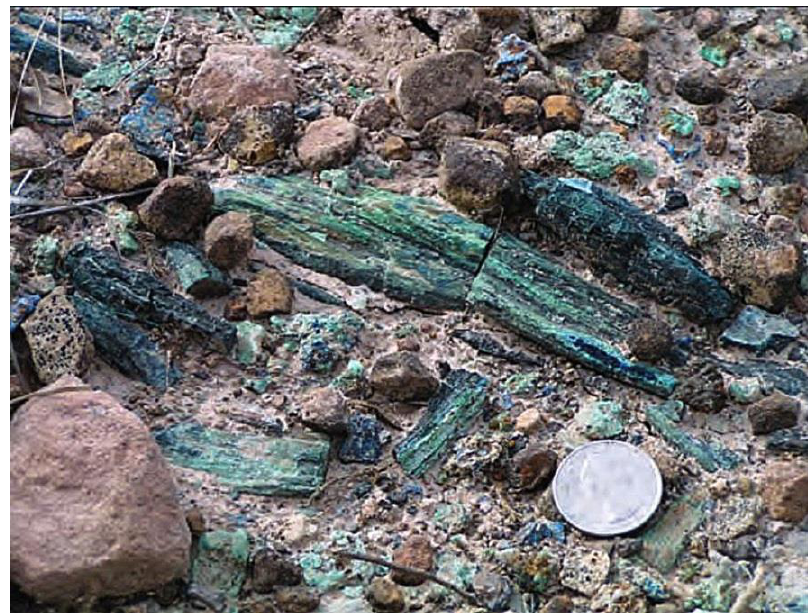
Figure 18. Copper-mineralized wood from Lower Permian Matfield Shale, Pawnee Oklahoma USA. Oklahoma Geological Survey photo by N.H. Suneson. Diameter of coin is 25 mm.